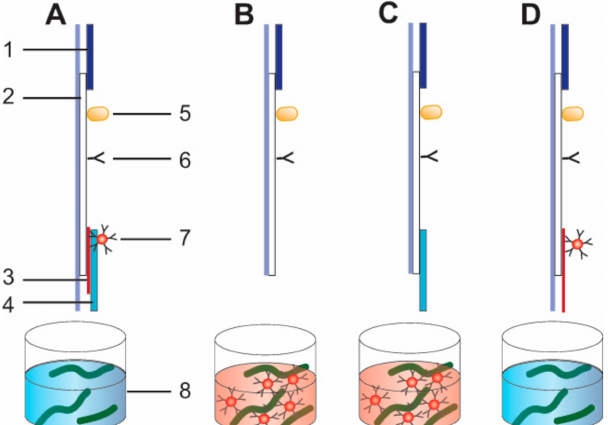
Figure 1. Schemes of lateral flow test strips. ( A ) Conventional lateral flow test strip with a conjugate pad. ( B ) Lateral flow test strip with pre-mixing and assembly without sample pad. ( C ) Lateral